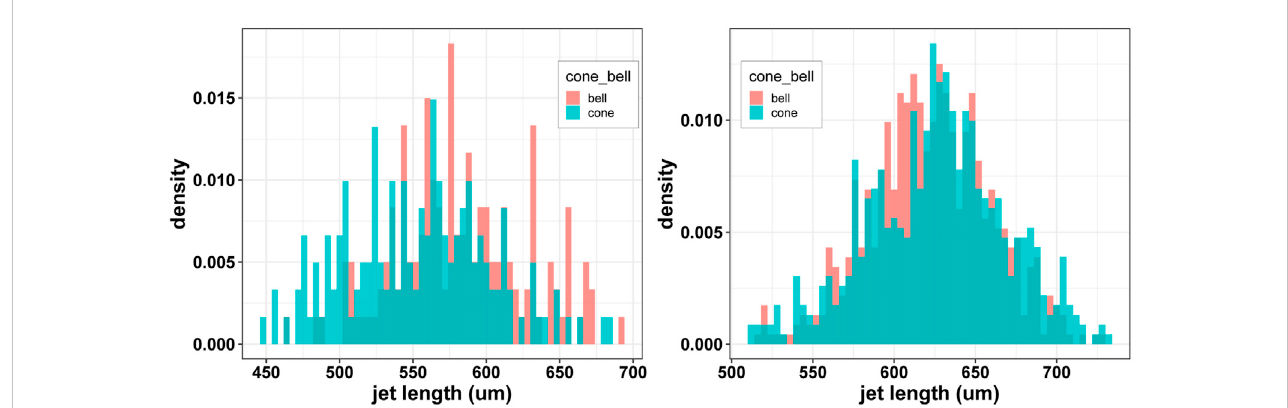
FIGURE 14 Numerical simulation results of the cone-shaped and bell-shaped nozzles (left) and experimental results of the cone-shaped and bell-shaped nozzles (right). The operating conditions are 48 μ L/min for the liquid (water) fl ow rate and 6 mg/min for the sheath gas fl ow rate.